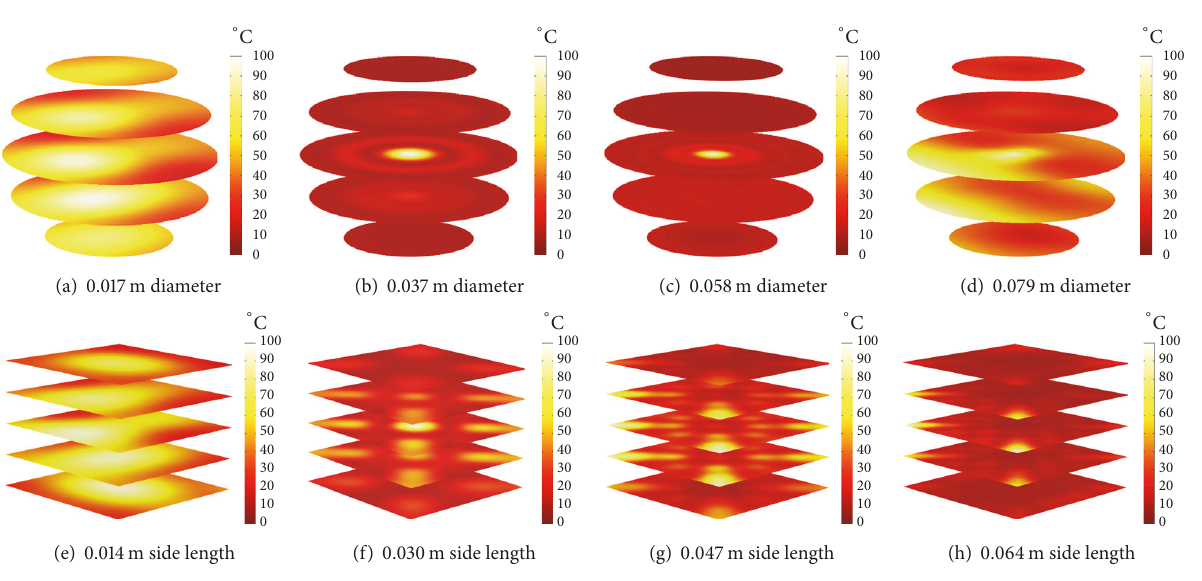
Figure 15: Spatial distribution of temperature in